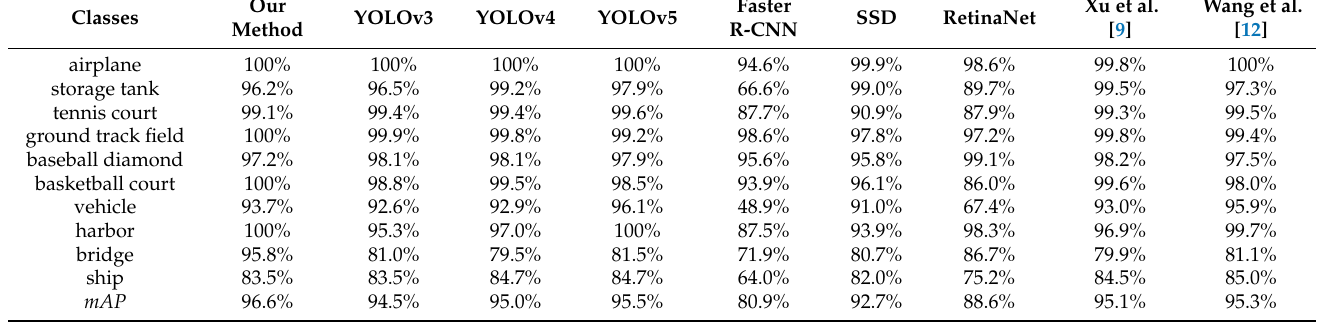
Table 3. The experimental results on the NWPU VHR ‐ 10 dataset.